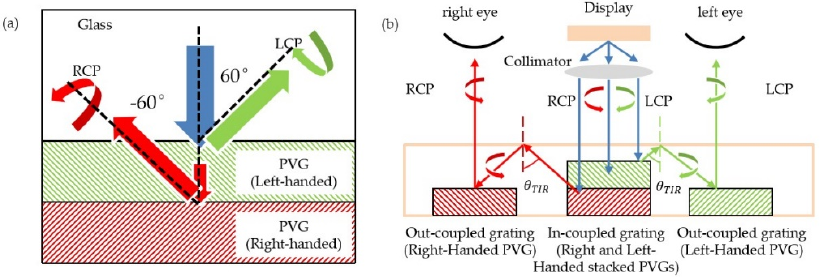
Figure 10. Schematic drawing for (a) the dual-layer polarized volume gratings (PVGs) used as an in-coupled grating of the planar waveguides in a 2D/3D wearable display device (b) .